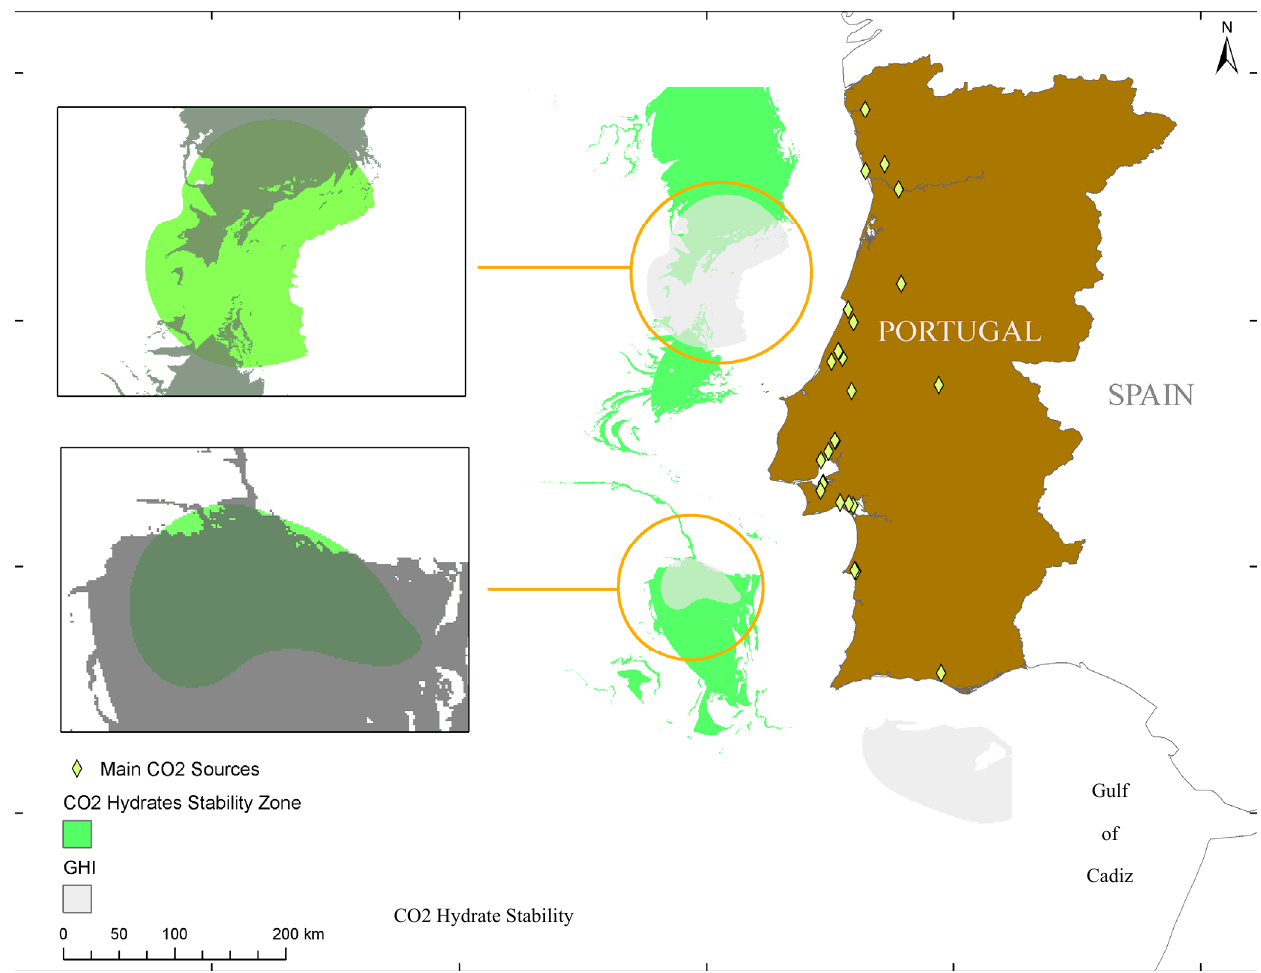
Figure 7. Overlap of preferential areas for CO 2 storage in hydrate form with GHI